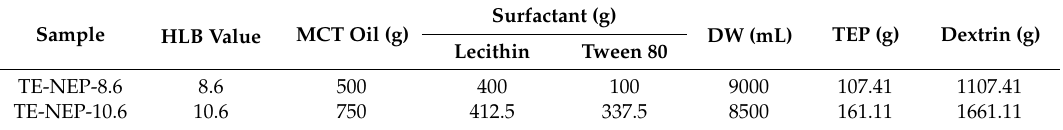
8.6; TE-NEP-10.6, turmeric extract-loaded nanoemulsion powder with HLB value of